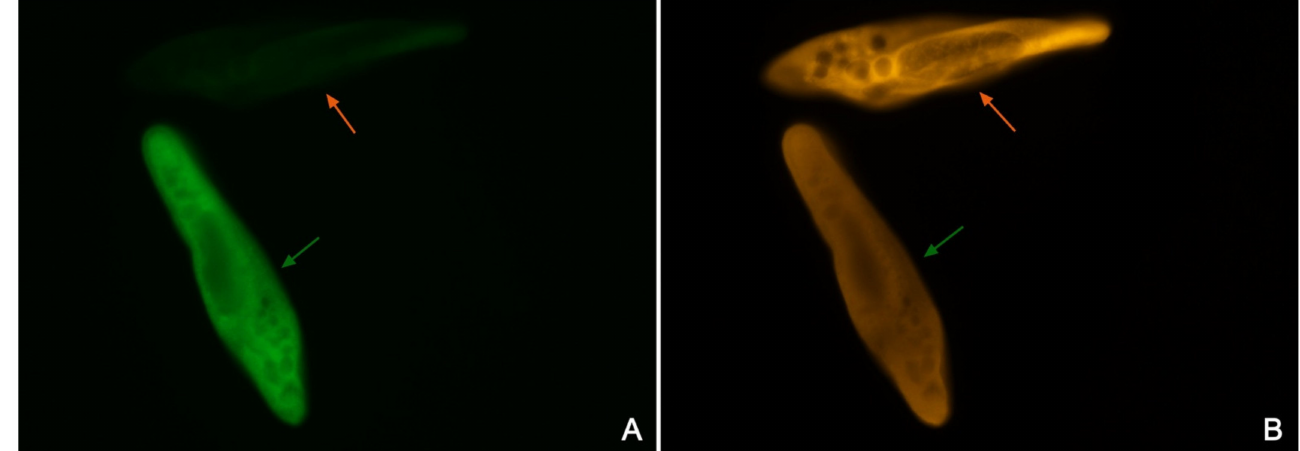
Figure 5. Discrimination of representatives of P. multimicronucleatum groups I and II by FISH: ( A ) mixed cells of both groups hybridized with Paramulti probe (green signal) specifically designed for group I; ( B ) mixed cells of both groups hybridized with Parafok probe (orange signal) specifically designed for group II. The cell of group I is marked with a green arrow, and that of group II is with an orange arrow. Paramulti probe appeared to be efficient at exclusively detecting representatives of strains belonging to group I (cell marked with an orange arrow on ( A ) remains almost invisible), while Parafok bound to cells of both